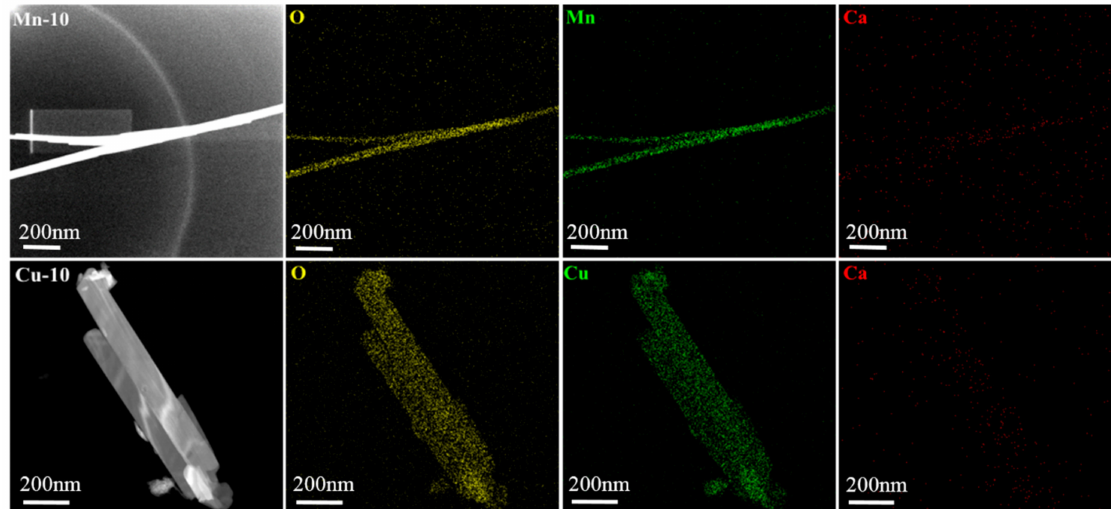
Figure 4. Energy dispersive spectrometer (EDS) mapping images of new precipitates from Mn-10 and Cu-10 after dissolution for 2880 h.